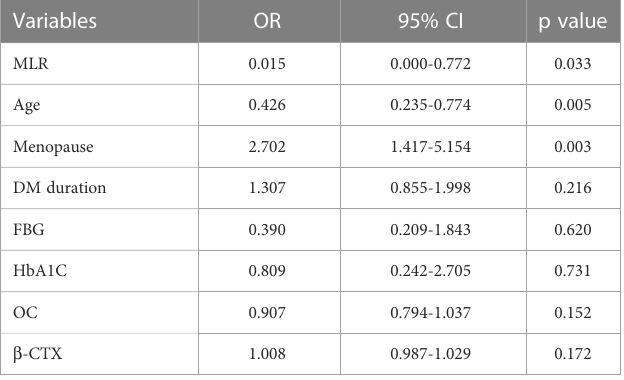
TABLE 2 Logistic regression analysis showing independent predictors of Osteoporosis in postmenopausal females with T2DM.